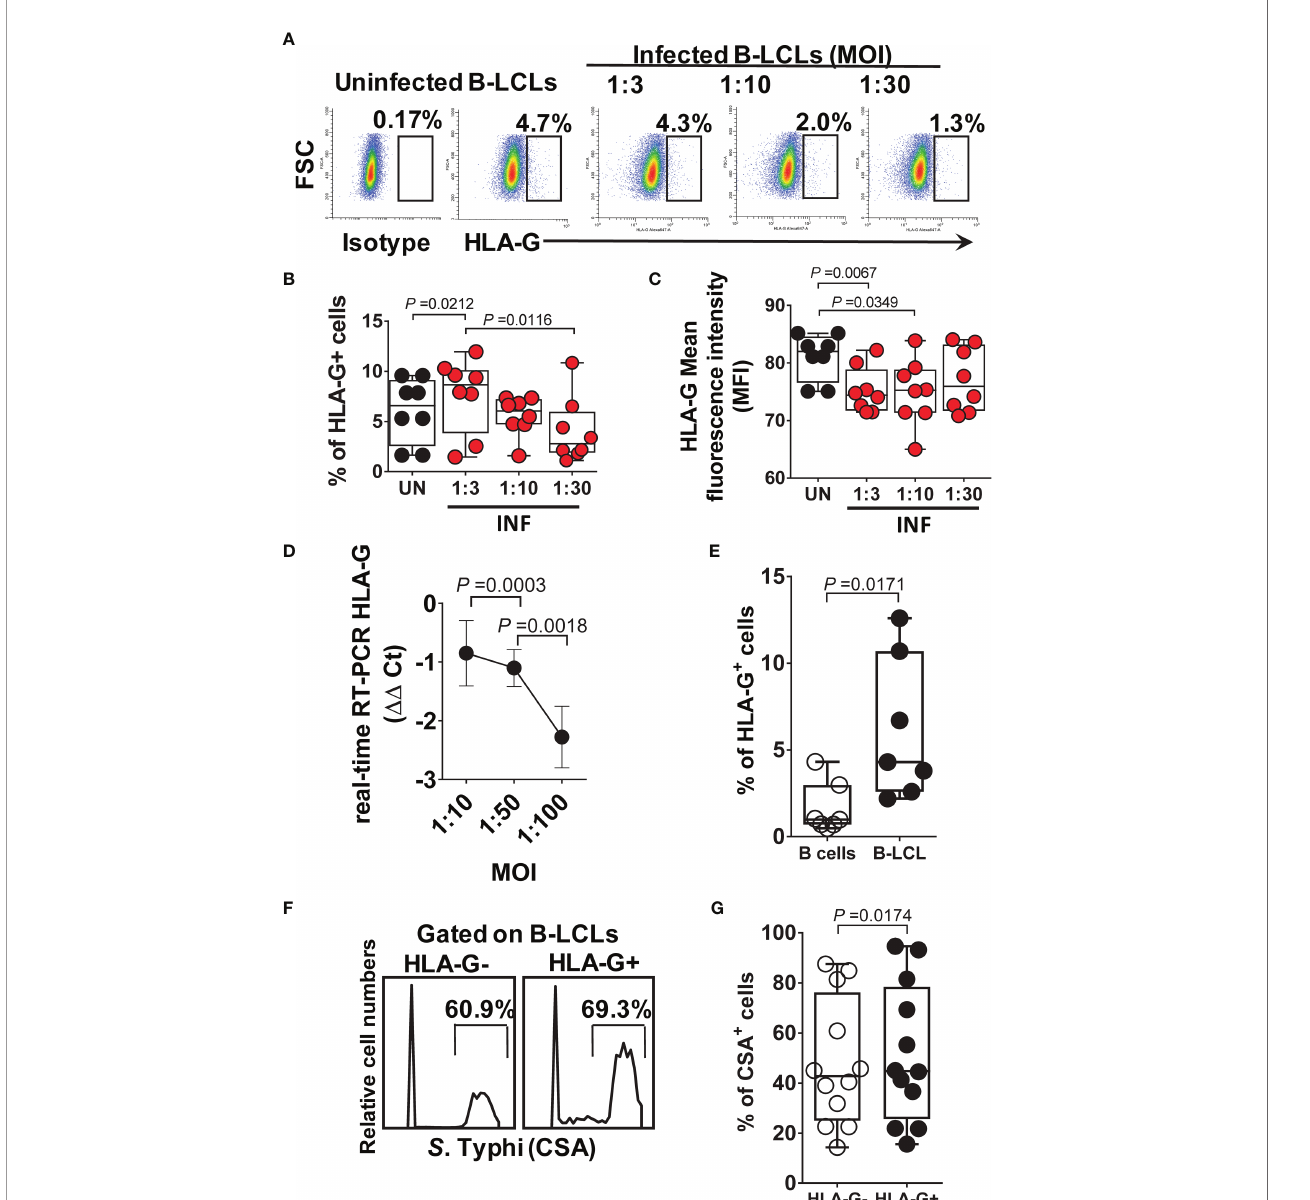
FIGURE 2 | HLA-G expression on B cells. B-LCLs were infected with S . Typhi for 3 hours at different cell:bacteria multiplicity of infection (MOI). Uninfected cells were used as controls. After 16-18 hours of gentamicin treatment, cells were stained with anti-HLA-G mAbs and analyzed by fl ow cytometry. (A) Percentage of B- LCL cells expressing HLA-G on the surface. Cumulative HLA-G (B) percentage and (C) mean fl uorescence intensity (MFI). Bar graphs extend from the 25 th to 75 th percentiles; the line in the middle represents the median of the pooled data. The whiskers delineate the smallest to the largest value. (D) real-time RT-PCR for HLA- G. Data are representative of one out of fi ve independent experiments with one volunteer and six replicates. (E) HLA-G expression on B-LCLs from healthy individuals. Each dot represents one volunteer. (F) S . Typhi infection levels in live HLA-G- and HLA-G+ B-LCLs, Representative experiment. (G) Cumulative % of CSA+ cells. Data are representative of one out of six independent experiments with 4 volunteers and 2